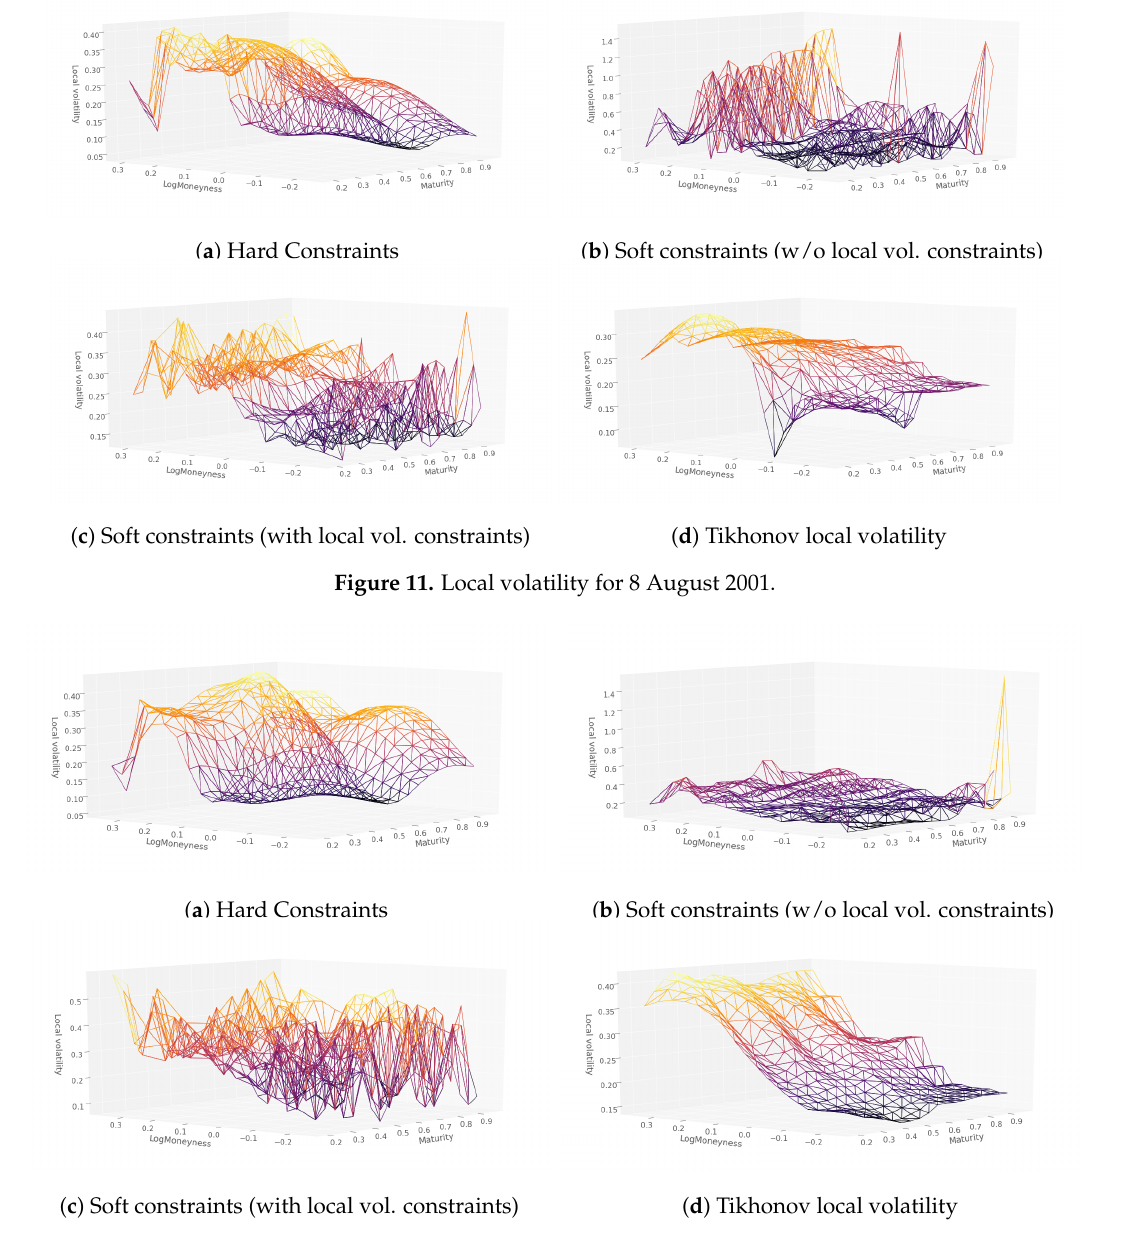
Figure 12. Local volatility for 9 August